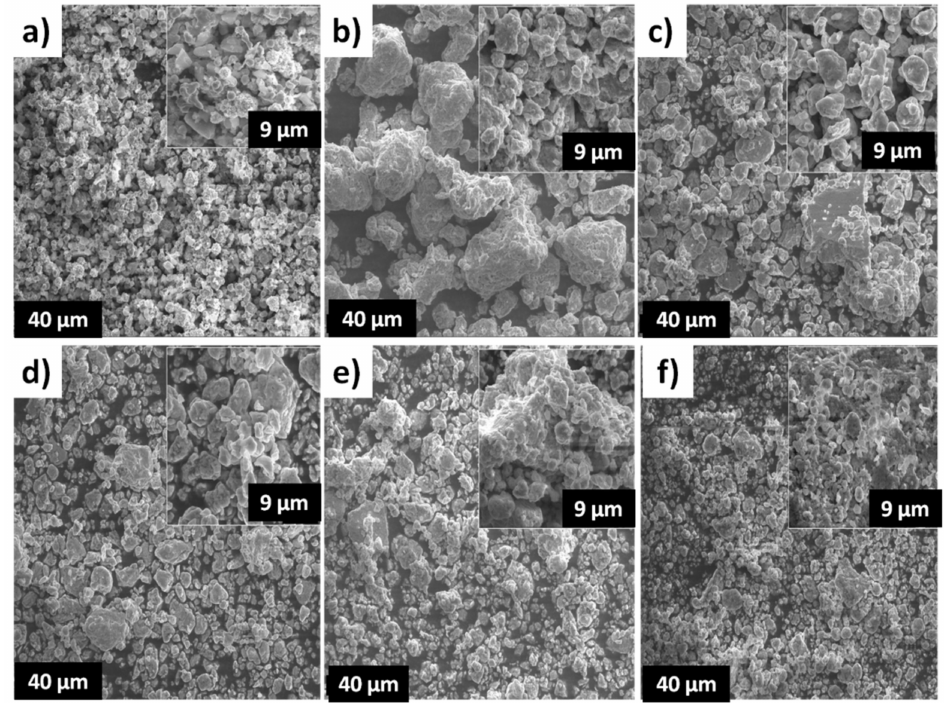
Figure 1. Scanning electron micrographs (SEM) of mechanically milled powders: ( a ) 0 h, ( b ) 5 h, ( c ) 25 h, ( d ) 50 h, ( e ) 100 h and ( f ) 150